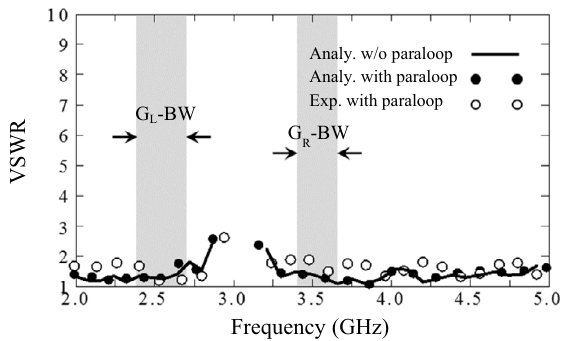
Fig. 9. Frequency response of the VSWRs in the presence and absence of a parasitic loop (paraloop). The 3-dB gain-drop bandwidths for G L and G R are denoted as G L -BW and G R -BW,